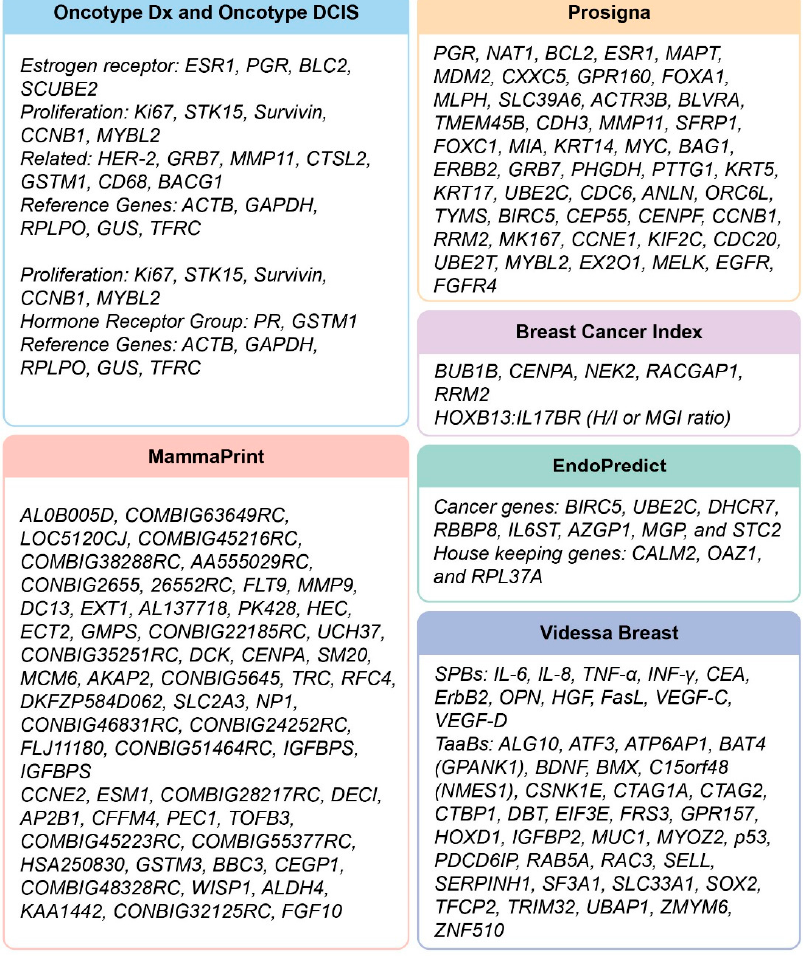
Figure 2. Gene / protein signatures of the prognostic / predictive multigene tests for breast cancer. SPBs Figure 2. Gene/protein signatures of the prognostic/predictive multigene tests for breast cancer. SPBs [Serum Protein Biomarkers]; TaaBs [Tumor-associated autoantibodies]. [Serum Protein Biomarkers]; TaaBs [Tumor-associated